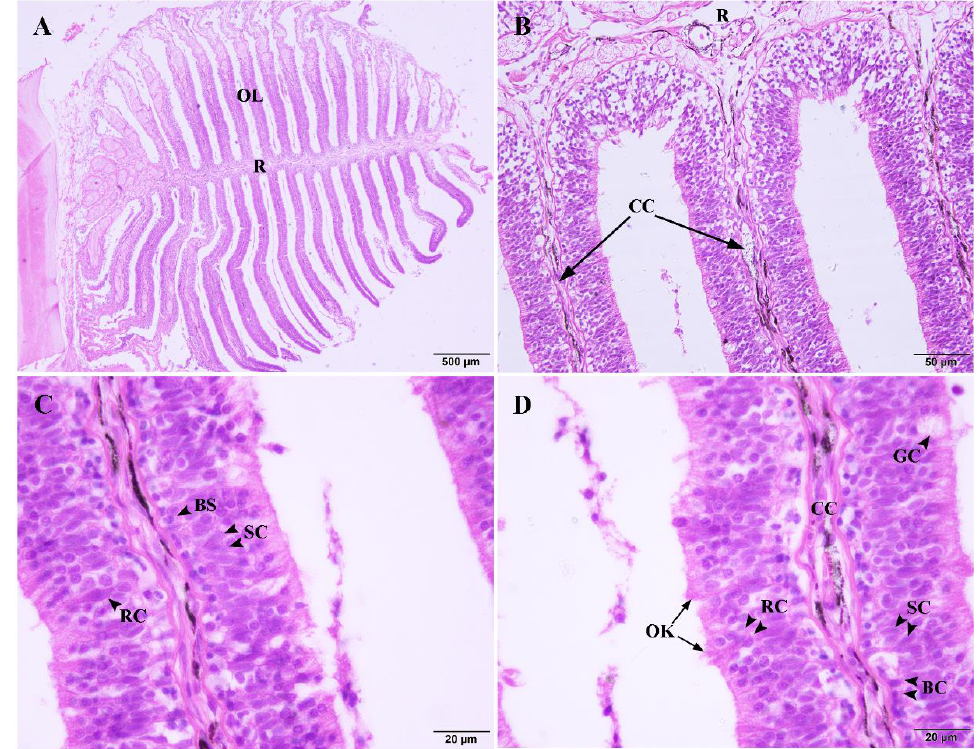
Figure 1. Semithin section of OE stained with H.E. (5 μm). ( A ) OE of blunt snout bream (40×). R, olfactory raphe; OL, olfactory lamellae. ( B ) Olfactory lamellae of blunt snout bream (400×). CC, central core (black arrow). ( C , D ) Olfactory lamellae of blunt snout bream (1000×). CC, central core; RC, olfactory receptor cell; GC, goblet cell; BC, basal cell; SC, support cell; OK, olfactory